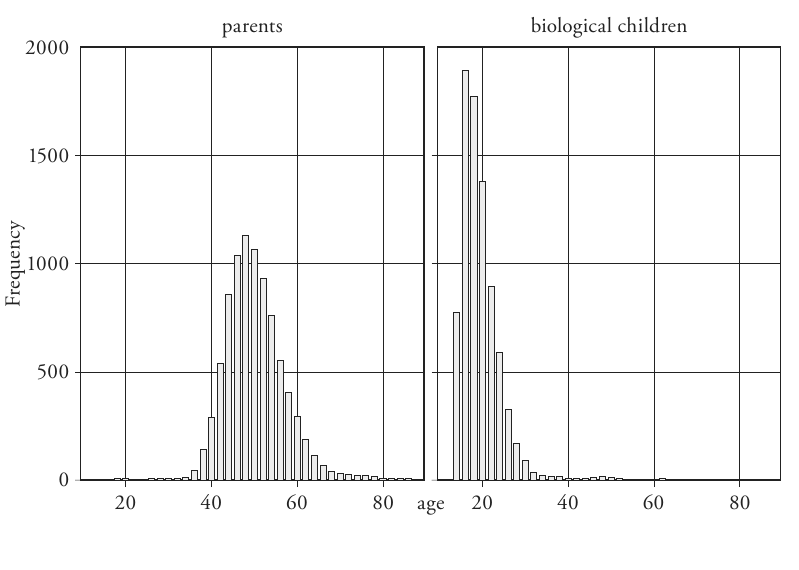
Figure 2: Age Distribution of Parents and their Biological Children